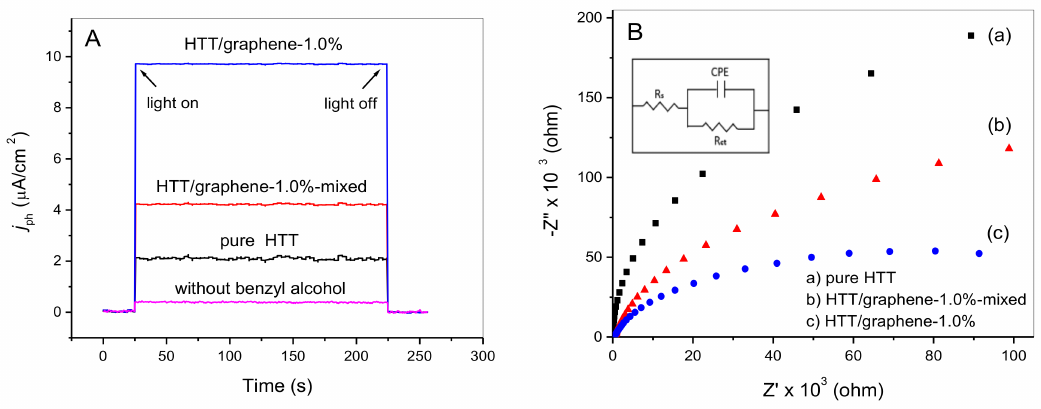
Figure 11. ( A ) Photocurrent curves of pure HTT, HTT/graphene-1.0%-mixed, and HTT/graphene-1.0% electrodes under visible light irradiation; the violet curve represents the photocurrent response over HTT/graphene-1.0% electrode without benzyl alcohol in the electrolyte solution. ( B ) Electrochemical impedance spectra (EIS) Nyquist plots of the pure HTT, HTT/graphene-1.0%-mixed, and HTT/graphene-1.0% samples under light irradiation with a Xe lamp. Inset: Electrical equivalent circuit supposed for fitting of impedance spectra. R S , CPE, and R ct represent the electrolyte resistance, space charge capacitance, and the charge transfer resistance,